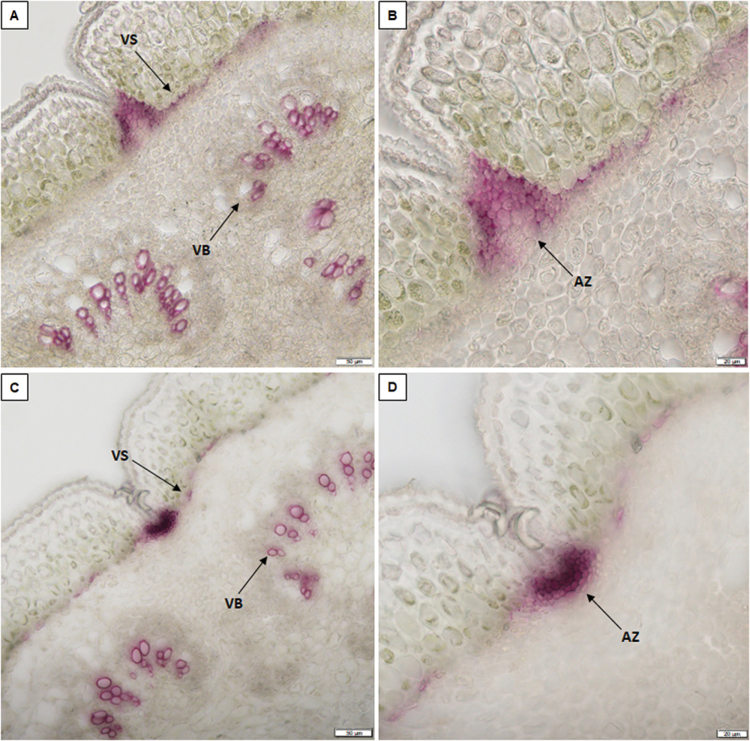
Analysis of lignification patterns in the ventral sheaths of 6-day-old pods of the totally indehiscent variety Midas and the highly dehiscent IL 244A/1A. Cross-sections (section thickness, 30 µm) of pods of Midas (A, B) and 244A/1A (C, D) after phloroglucinol staining for lignin. (B, D) Increased magnification from (A, C). Scale bars: 50 µm (A, C); 20 µm (B, D). VS, ventral sheath; VB, vascular bundles; AZ, abscission zone.